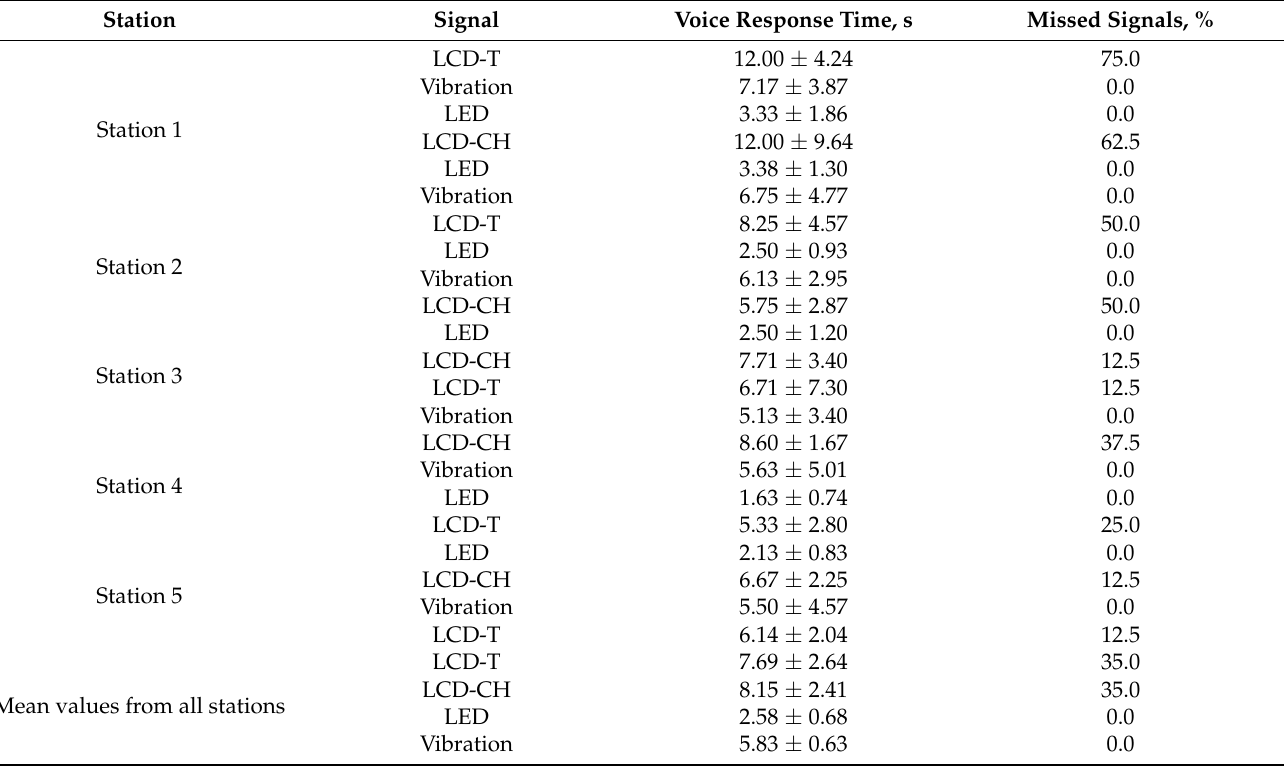
Table 4. Test results of the voice response time to the signal.